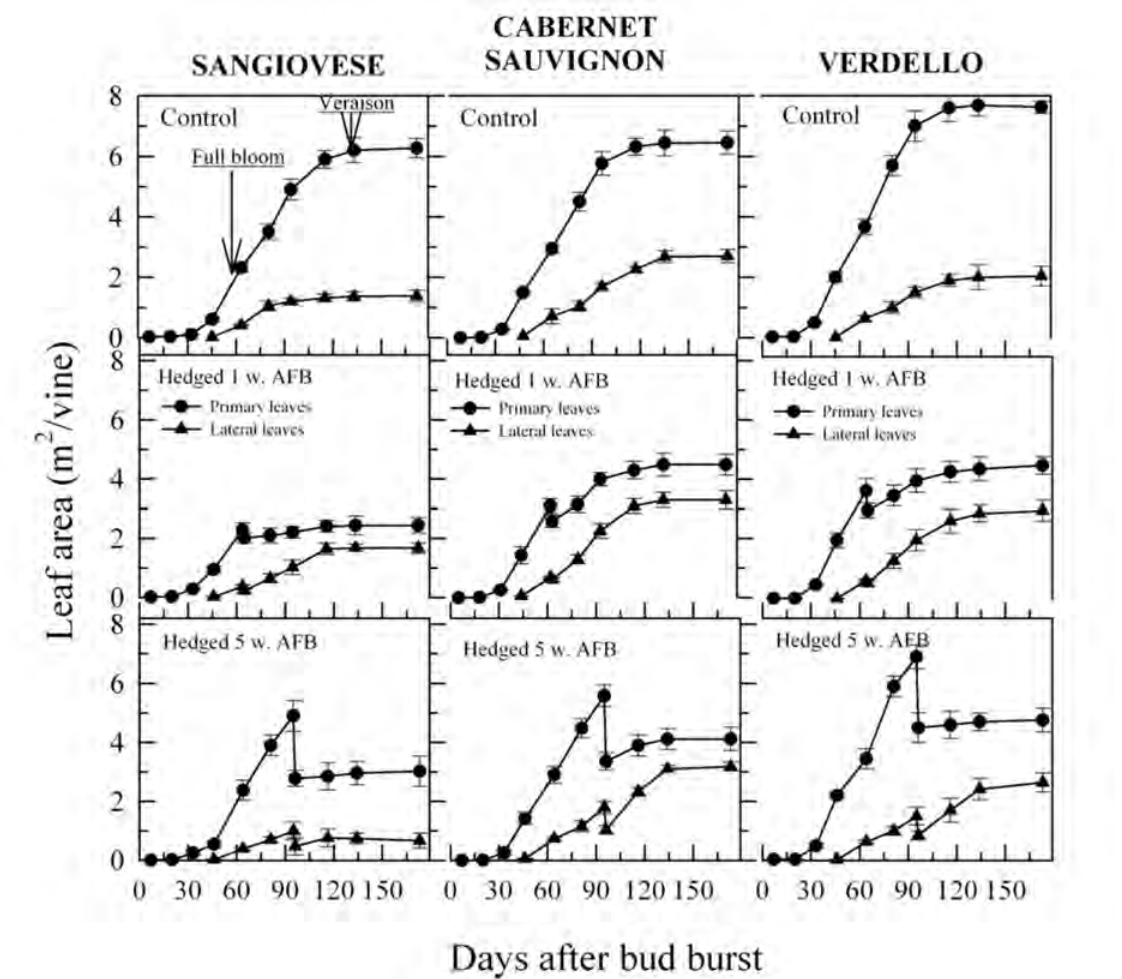
Fig. 5 - Development of primary and lateral leaves in Sangiovese, Cabernet Sauvignon and Verdello grapevine cultivars hedged one and five weeks after full bloom (AFB) as compared to the untrimmed control (n = 3 ± se